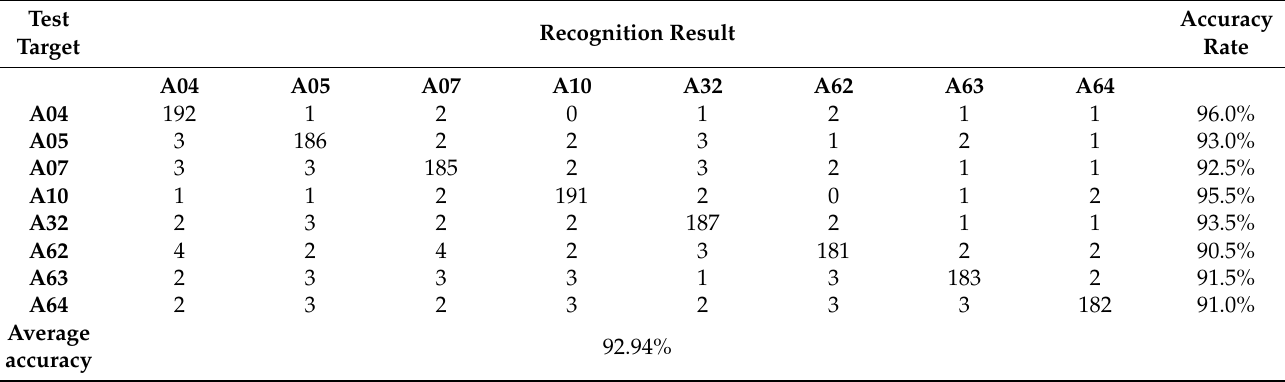
Table 7. Target recognition results with pretraining and loss function